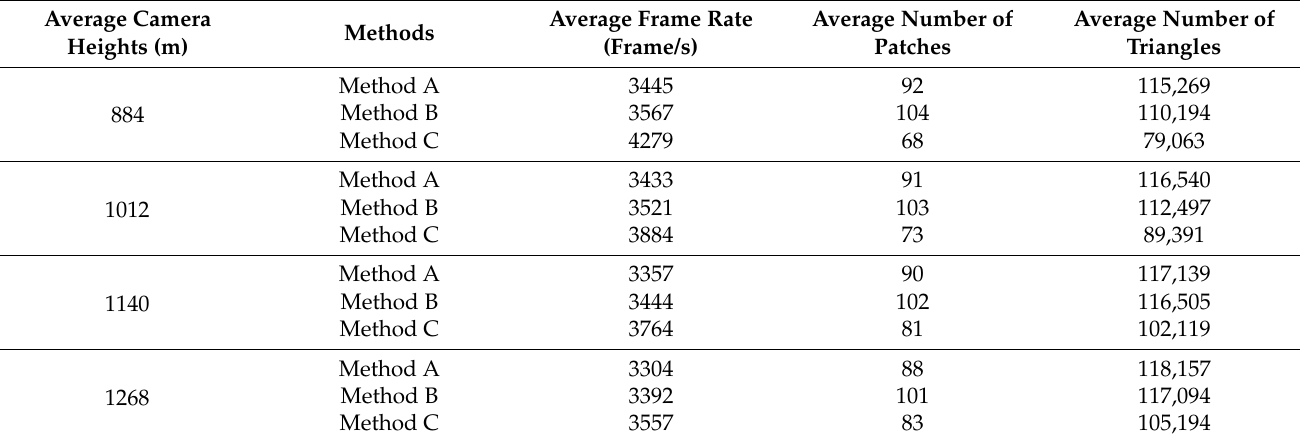
Table 2. Comparison among different